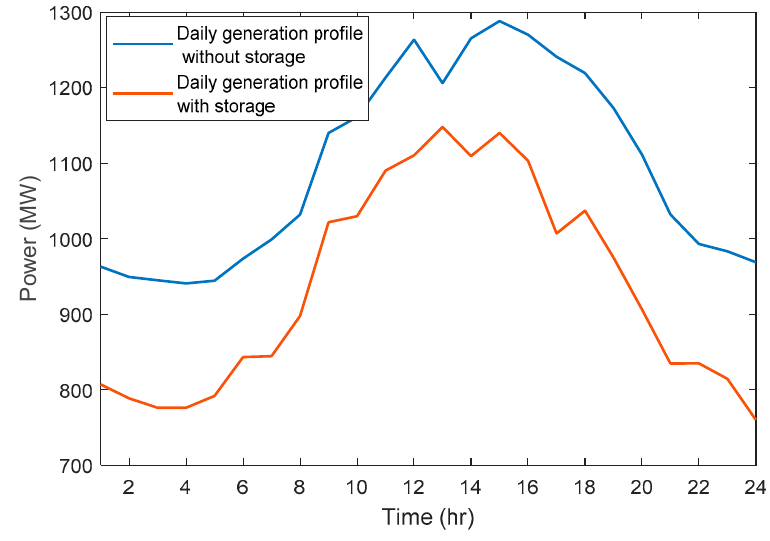
Figure 10. Thermal units’ overall generation profile.